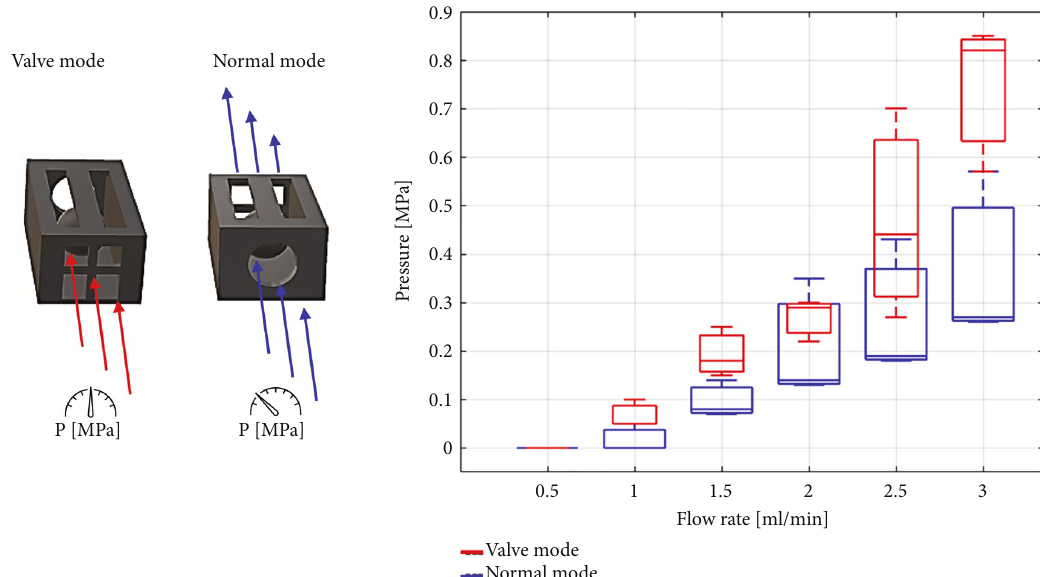
Figure 6: Flow experiment. The devices were tested in both directions, valve mode and normal mode, at di ff erent fl ow rates of 0.5, 1, 1.5, 2, 2.5, and 3 ml/min to verify the operation of the one-way